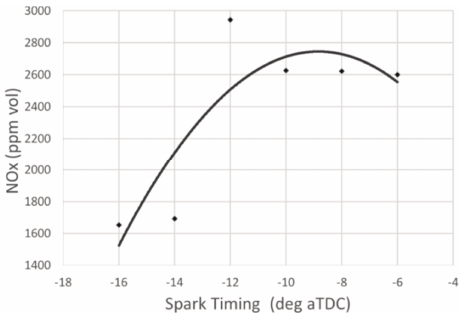
Fig. 5. NO x emission as a function of the spark timing